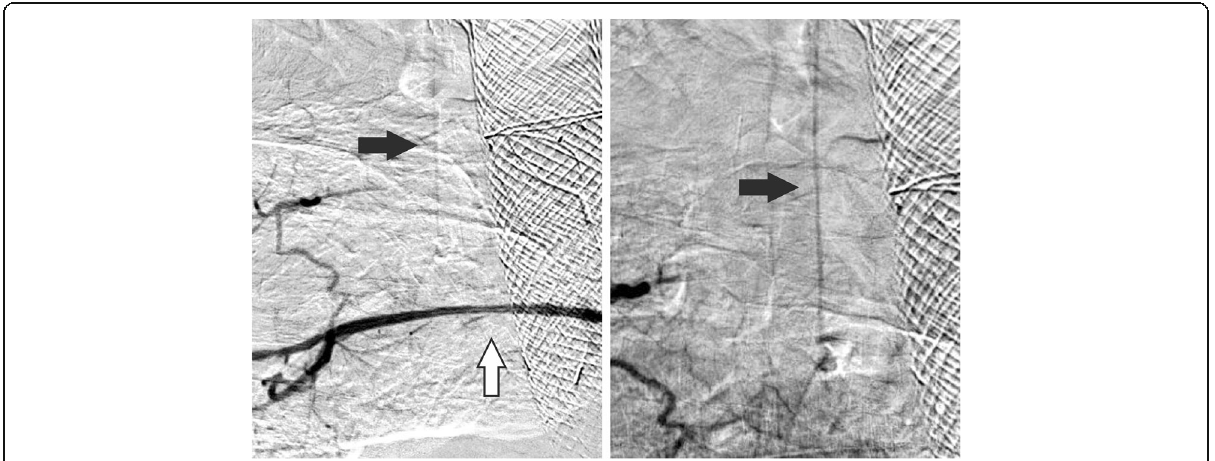
Fig. 2 DSA after implantation of the PK Papyrus Stent. After implanting the stentgraft in the proximal segment of the intercostal artery, the pseudoaneurysm is no longer perfused (white arrow) minimizing the risk of recurrent bleeding. At the same time, the perfusion of the anterior spinal artery is preserved (black arrow) minimizing the risk of spinal